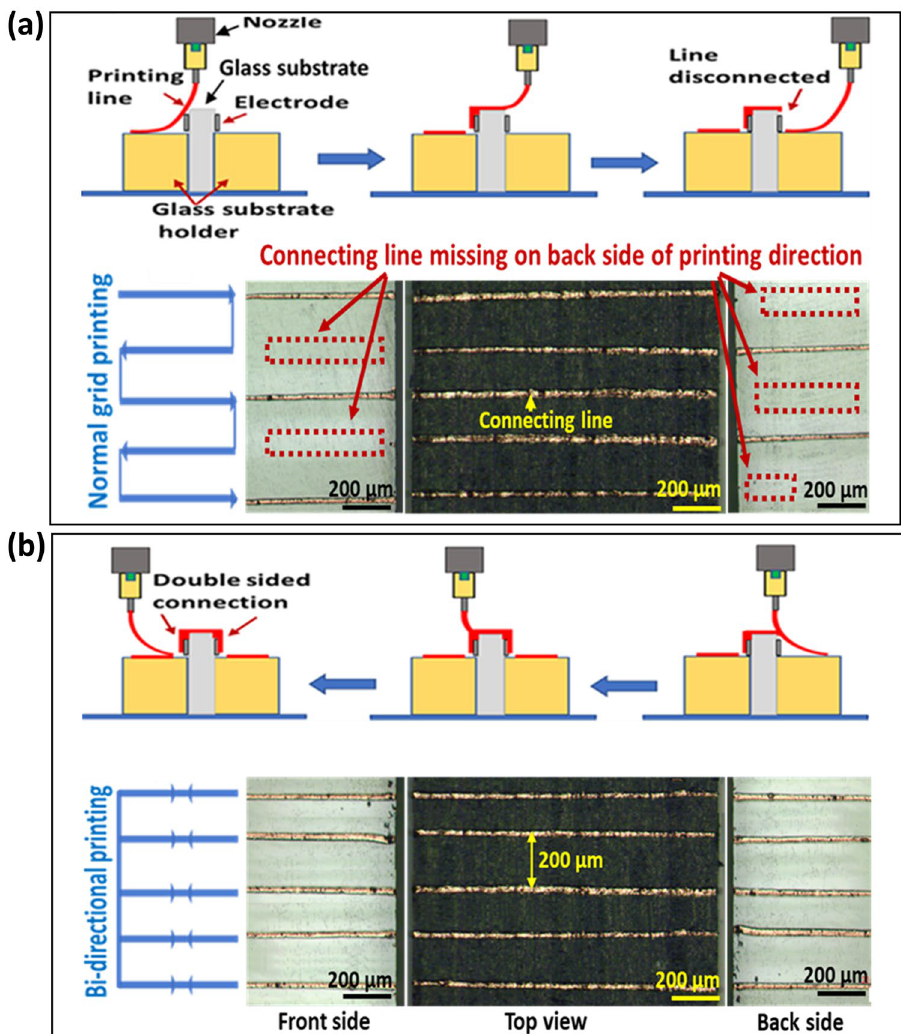
Figure 3. Printing methods and the typical printed results on each side of the glass. ( a ) Unidirectional printing results, and ( b ) Bi-directional printing